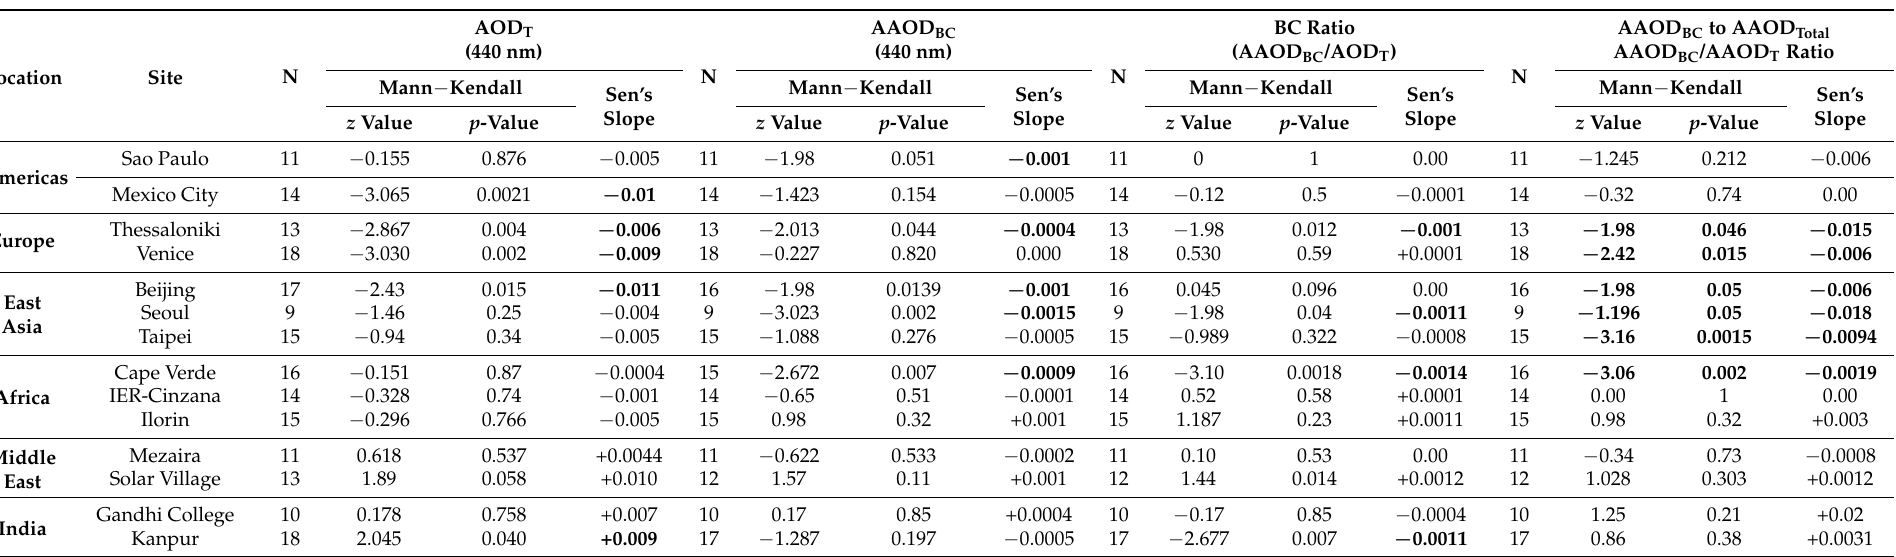
Table 3. Location, sites, number of observations used in the analysis (N), the Mann − Kendall z and p values, and Sen’s slope for AOD T , AAOD BC , BC